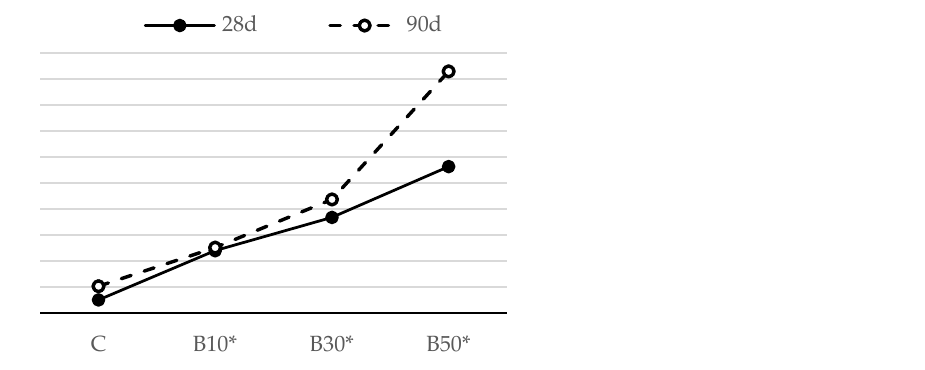
Figure 16. Compressive strength of mortars blended with biomass ash, with decreased w/b. The compressive strength results show a similar development in trend as that of flexural strength. At the age of 28 days, the compressive strength of the CP10*, CP30* and CP50* samples rose by 18%, 22% and 63% in relation to the reference mortar, respectively, while the compressive strength of B10*, B30* and B50* improved by 16%, 27% and 44%, respectively.